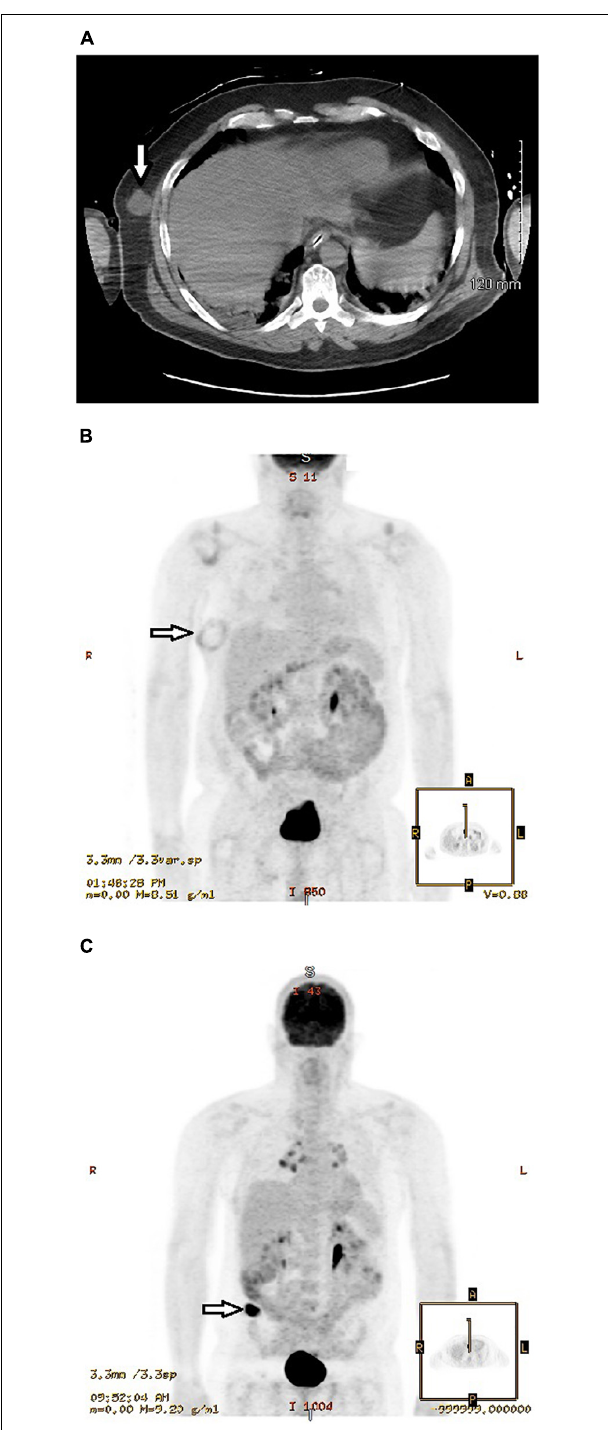
FIGURE 1 | (A) Initial CT scan of chest without contrast performed 27 July 2020 showed extensive patchy ground-glass infiltrates throughout both lungs and an incidental 2.4 cm diameter nodular mass (arrow) in the right lateral lower chest wall of indeterminate significance and etiology. He underwent excision of the nodule on 23 October 2020. (B) Positron emission tomography (PET) scan performed 30 October 2020, 1 week after excision of